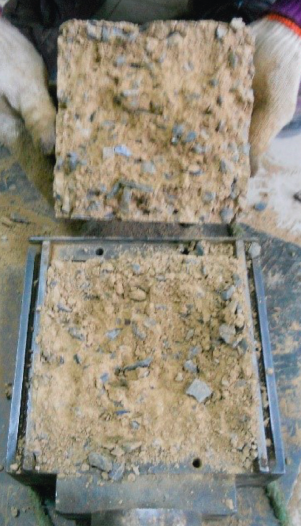
Figure 13: Samples of SRMCM after the indoor direct shear